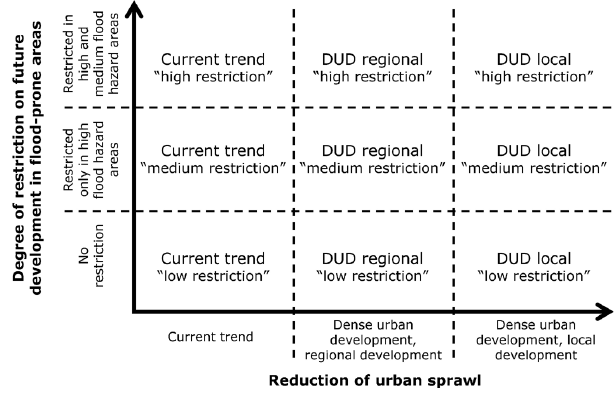
Fig. 7. Summary of the nine urbanization scenarios characteristics according to two criteria. Table 2. Exclusion areas, defined based on the PLI and land registry database, as well as on additional data for non-registered land use categories (hydrography, road network,